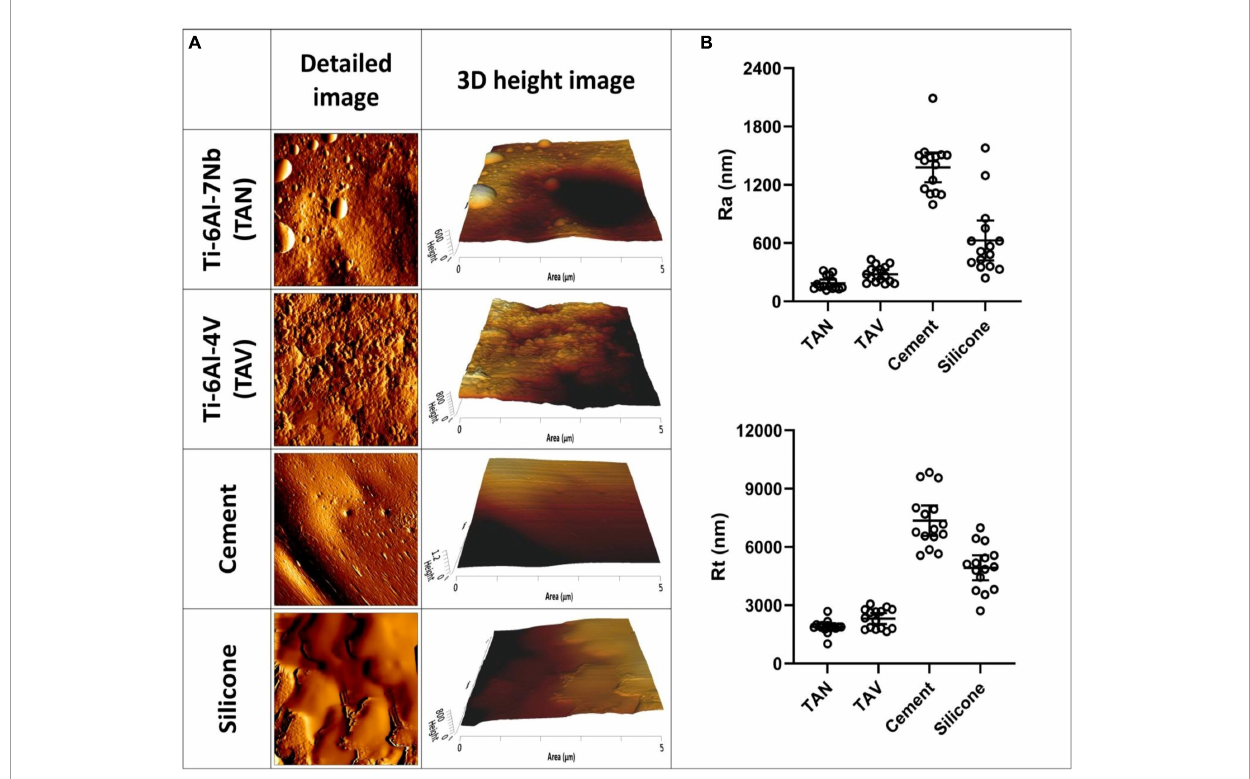
FIGURE1 Atomic force microscopy images of various implant materials. (A) Per material and per timepoint a detailed 5 µ m × 5 µ m image and a 3D height image is given. (B) The corresponding surface parameters of these materials are shown. On the y -axis, the surface roughness Ra and peak-to-valley roughness Rt are shown. On the x -axis, the following materials are shown: Ti-6Al-7Nb (TAN); Ti-6Al-4V (TAV); orthopedic bone cement and silicone. Each datapoint represents one random location on a disk (3 disks; 5 areas each; N = 15). Horizontal lines indicate the means and error bars indicate 95% confidence